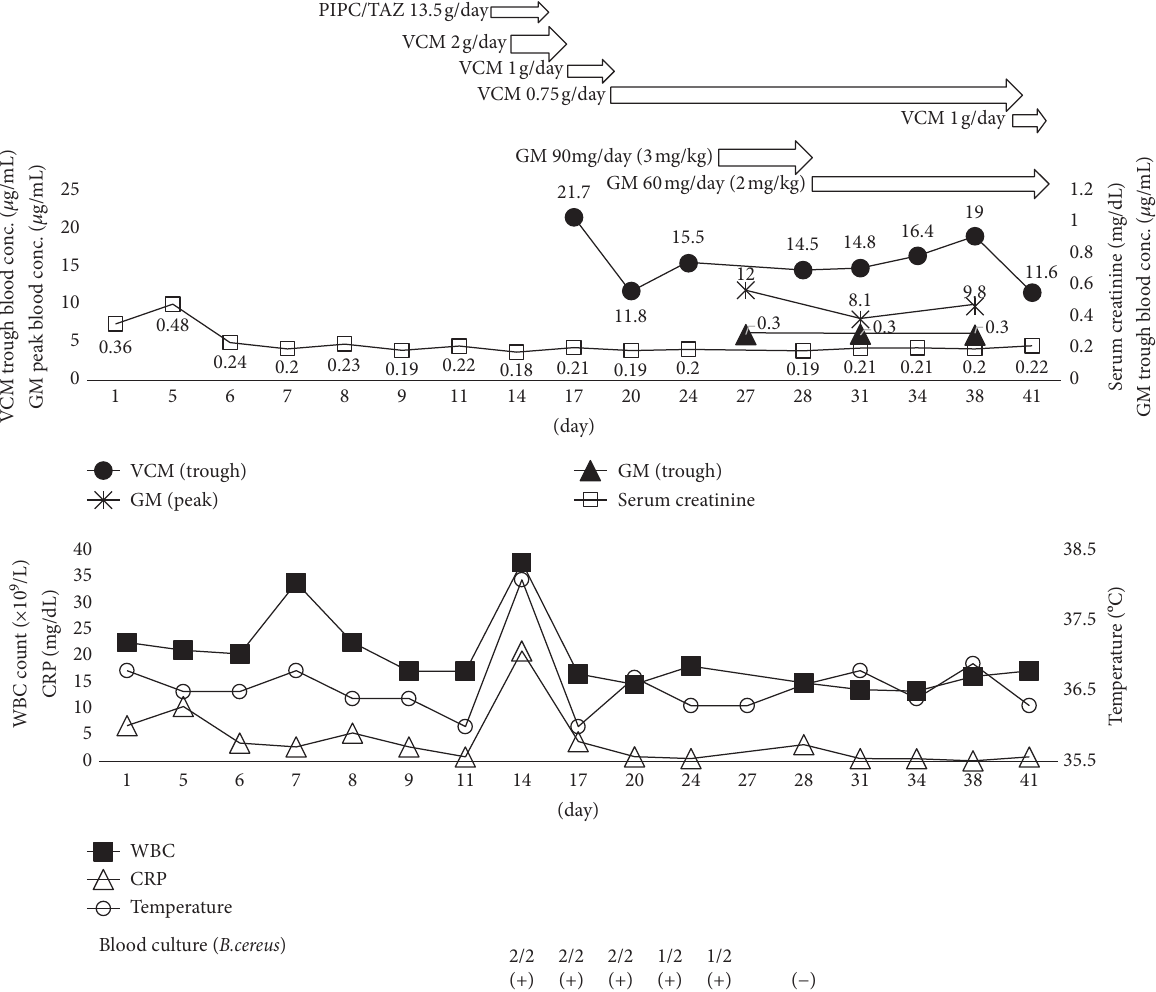
Figure 1: The patient’s clinical course. PIPC/TAZ: piperacillin/tazobactam, VCM: vancomycin, and GM: